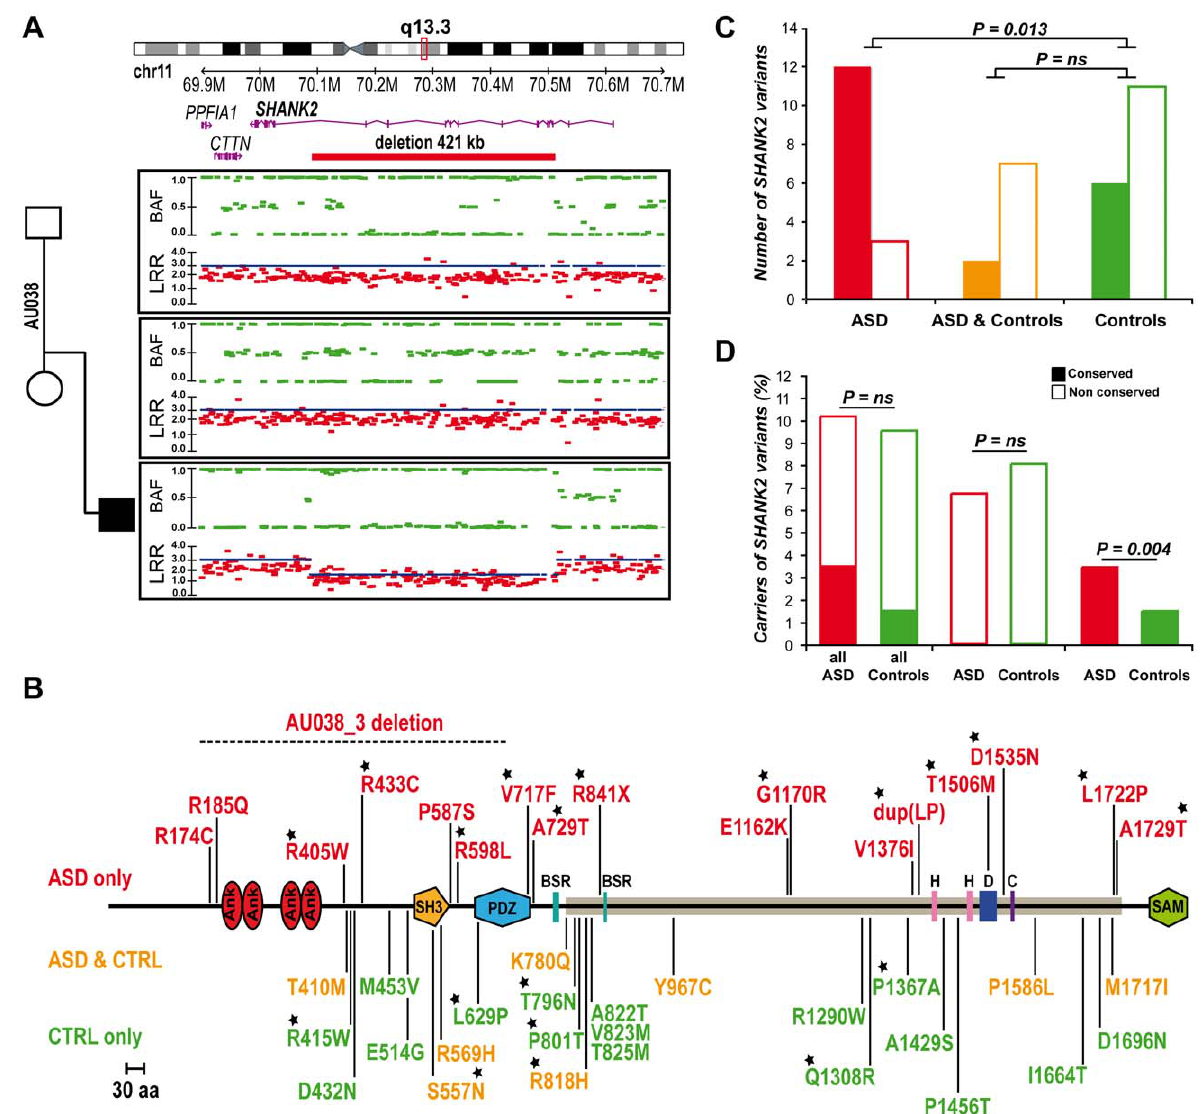
Figure 2. SHANK2 mutations in patients with ASD. A. A heterozygous deletion of SHANK2 was identified with the Illumina Human 1M-Duo SNP array in a patient with autism (AU038_3). The deletion spans 421 kb on chromosome 11q13.3, covers twelve exons of the human SHANK2 and is not present in the parents. Each dot shows Log R Ratio (LRR; in red) and B allele frequency (BAF; in green). QuantiSNP score is represented with a blue line and indicates the deletion size. B. Location of the CNV and sequence variants (from this study and Berkel et al. 2010) along the SHANK2 protein: in red the variations specific to ASD, in orange the variations shared by ASD and controls and in green the variations specific to controls [26]. The breakpoints of the SHANK2 deletion in AU038_3 are represented with a dotted line on the protein. Stars indicate the variants affecting conserved amino acids. C. A total of 40 variants were identified and variants affecting conserved amino acids in other SHANK proteins are enriched in patients with ASD (n conserved =12 and n non-conserved =3) compared with controls (n conserved =6 and n non-conserved =11) (Fisher’s exact test 1-sided, P=0.013, OR=6.83, 95% IC=1.19–53.40). D. The percentage of carriers of SHANK2 variants in patients with ASD and Controls. Variants affecting a conserved amino acid among the SHANK proteins are enriched in patients with ASD (n conserved =29 and n non-conserved =822) compared with controls (n conserved =16 and n non-conserved =1074) (Fisher’s exact test 1-sided, P=0.004, OR=2.37, 95% CI=1.23–4.70). Open squares and filled squares represent the non-conserved and conserved amino acids, respectively. ANK, Ankyrin repeat domain; SH3, Src homology 3 domain; PDZ, postsynaptic density 95/Discs large/zona occludens-1 homology domain; SAM, sterile alpha motif domain; BSR, brain specific region; H, homer binding site; D, dynamin binding site; C, cortactin binding site. The proline-rich region is represented as a horizontal gray